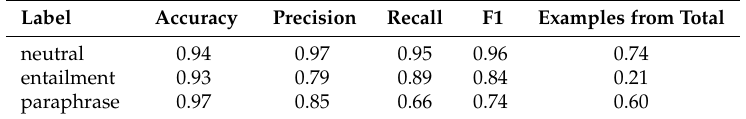
Table 6. ASSIN (PTPT + PTBR) NLI results per class, for the fine tuned ptBERT-Large model.